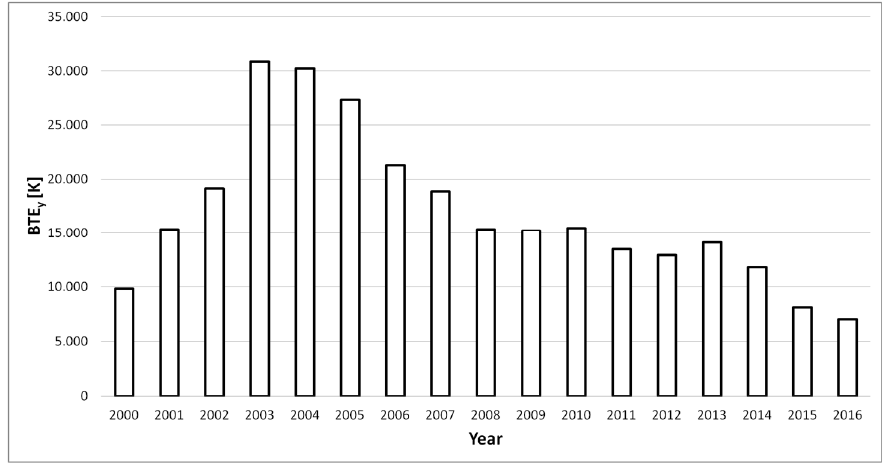
Figure 7. Flaring sites BTE y temporal trend.